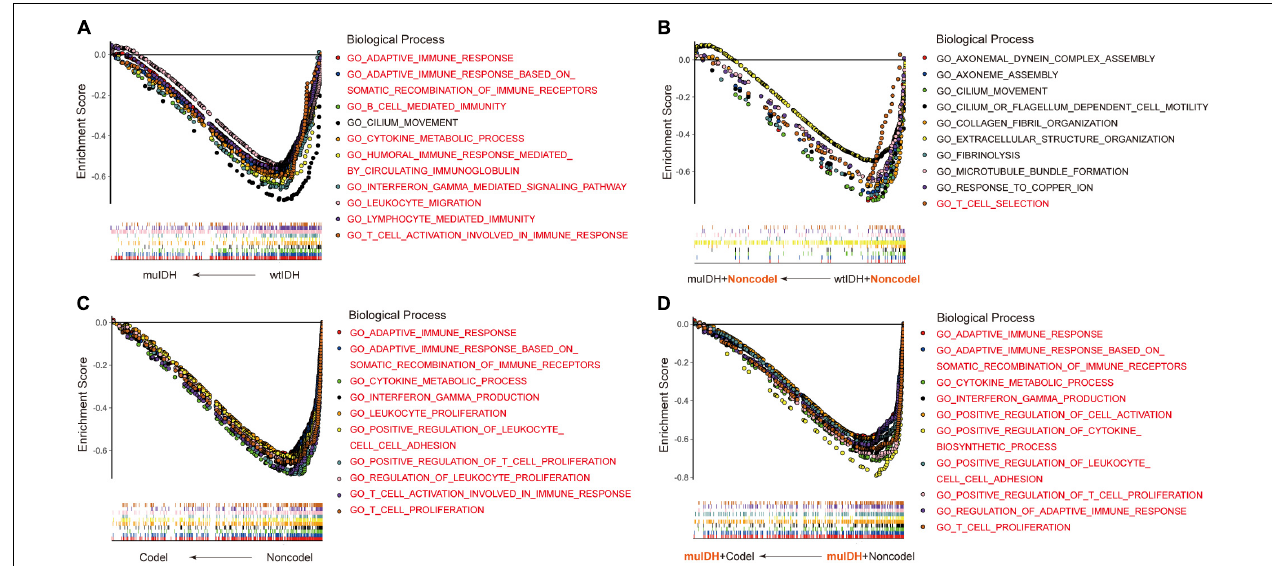
FIGURE 2 | Gene Set Enrichment Analysis (GSEA) using the human biological processes (BPs) gene set. (A) The top ten BPs negatively associated with IDH mutation status in LGGs. (B) The top ten BPs negatively associated with IDH mutation status in LGGs with 1p/19q non-codel. (C) The top ten BPs negatively associated with 1p/19q codel status in LGGs. (D) The top ten BPs negatively associated with 1p/19q codel status in LGGs with IDH mutation. The immune-related BPs were marked in